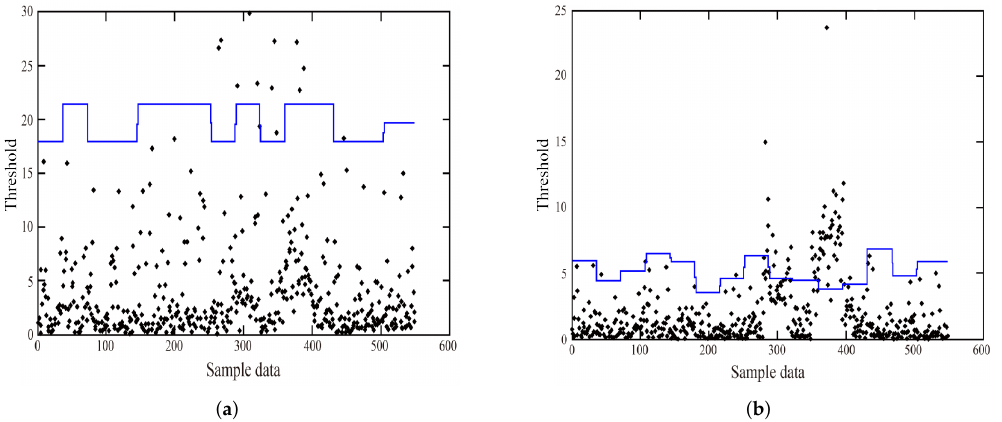
Figure 13. Control chart of improved MSPCA fault diagnosis model: ( a ) improved MSPCA- T 2 ; ( b ) improved